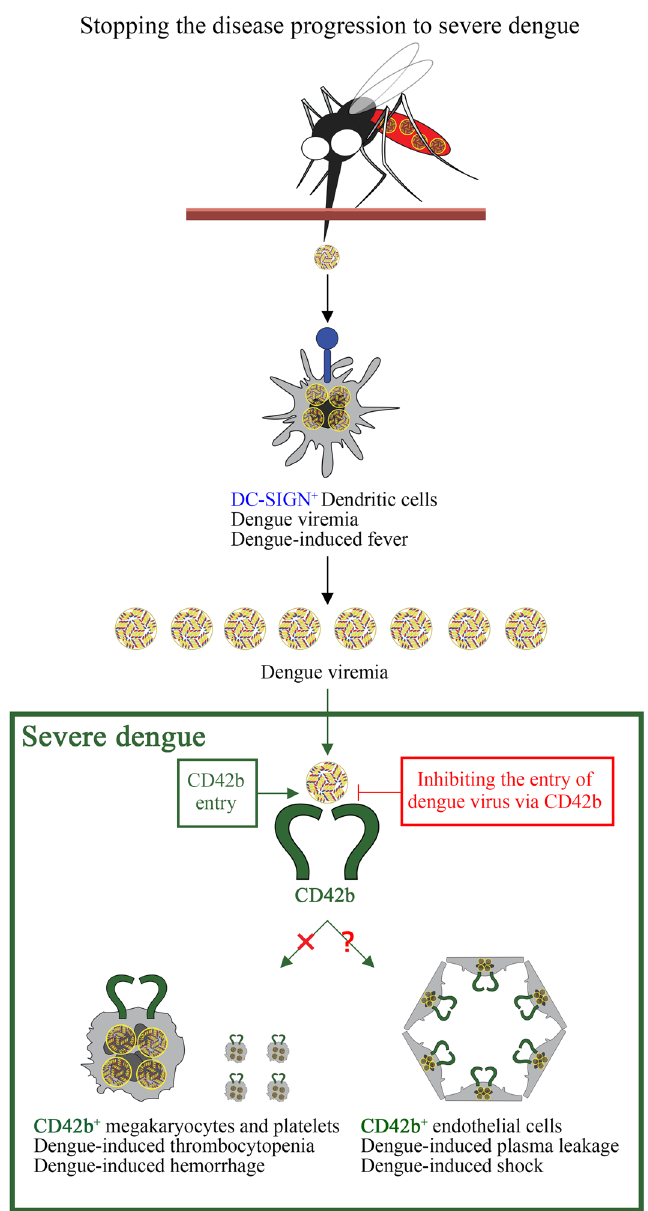
Figure 7. Proposed the strategy to stop the disease progression to severe dengue. Aedes aegypti inject DENV into human skin. Dendritic cells phagocytose and amplify DENV leading to viremia causing fever 4,38,39 . DENV in bloodstream may infect CD42b + mature megakaryocytes and platelets leading to thrombocytopenia causing hemorrhage. DENV may also infect CD42b + endothelial cells leading to plasma leakage causing shock. Inhibiting the binding of DENV to CD42b would be able to stop the disease progression from dengue fever to severe